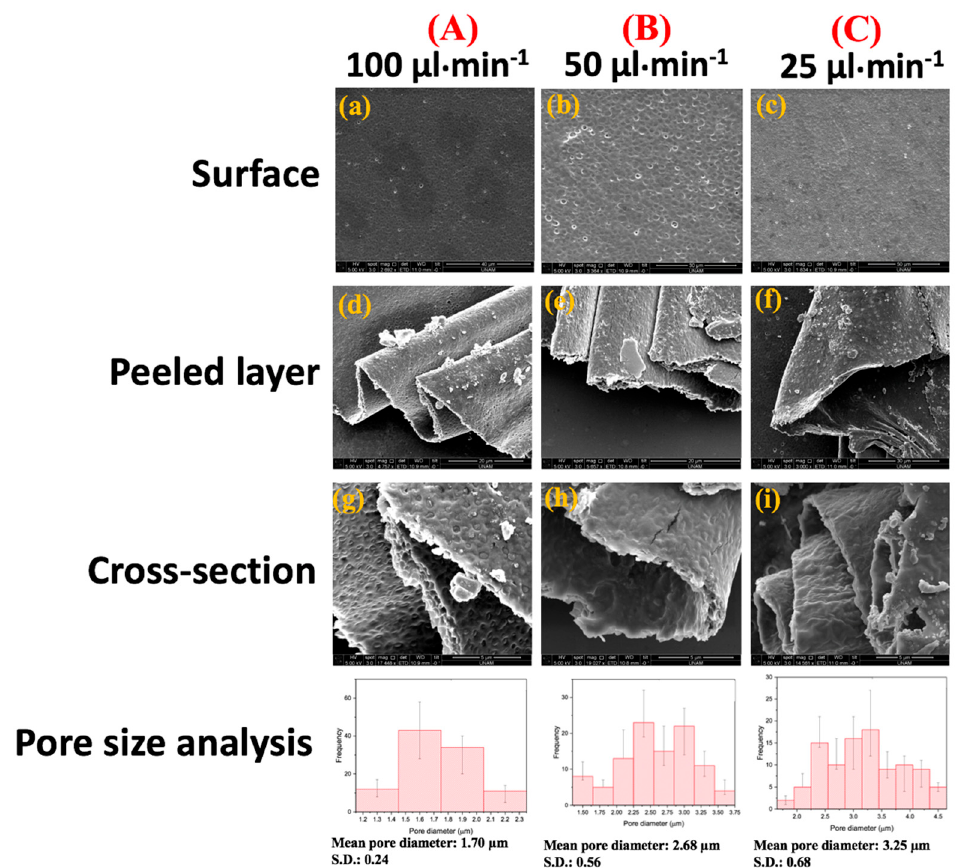
Figure 5. ( a–c ) SEM morphologies, ( d–f ) peeled surface, and ( g–i ) cross-sectional SEM images of the alginate-based porous films formed at a constant N 2 gas pressure of 0.8 bar in a range of various feeding liquid’s flow rates: ( A ) 100 µ L · min − 1 , ( B ) 50 µ L · min − 1 , and ( C ) 25 µ L · min − 1 (the polymeric solution consisted of 1 wt % alginate and 0.25 wt % PEG-40S in this experimental work). The data in the Pore size analysis graphs are presented as the mean values of standard deviation (SD) of 100